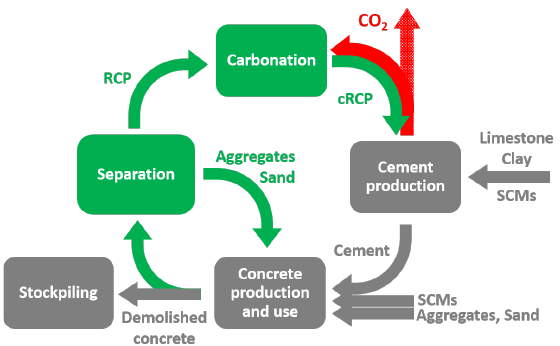
Figure 1. The life cycle of cement and concrete production including concrete recycling and recarbonation of the concrete fines. The part in gray shows the traditional way of production and use of cement. The green part highlights the improvements of improved concrete recycling and recarbonation associated with the concept discussed in this contribution. RCP – recycled concrete paste, cRCP – carbonated